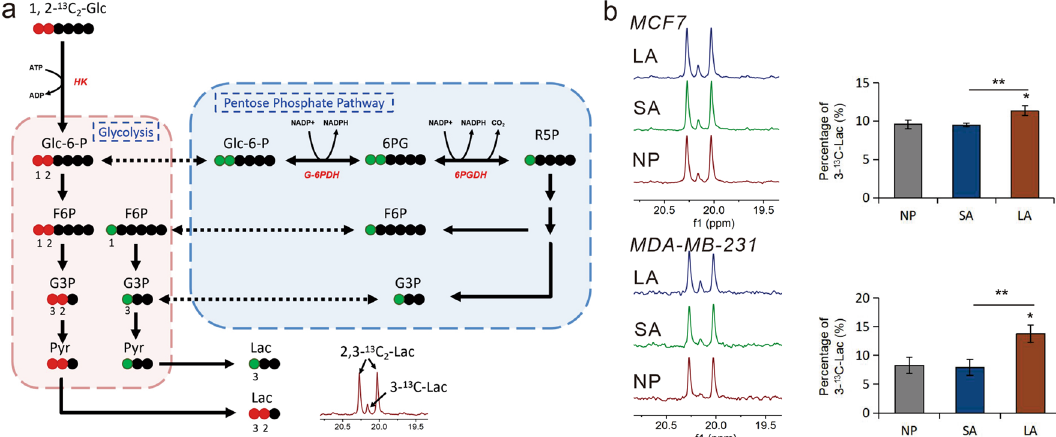
Figure 6. Metabolism of 1,2- 13 C 2 glucose through glycolysis and pentose phosphate pathway (PPP) with the labeling pattern of lactate. ( a ) The scheme shows the fate of individual carbons through glycolysis (red dots, 13 C) and PPP (green dots, 13 C), labeling in Glc-6-P, F6P, G3P, Pyr and Lac. Black dots represent 12 C atoms. ( b ) 13 C-NMR spectra (left) and the corresponding histogram (right) from MDA-MB-231 and MCF-7 media after cultured in NP, SA and LA. 3- 13 C-Lac (%) = [3- 13 C-Lac] / ([3- 13 C-Lac] + [2,3- 13 C 2 -Lac]